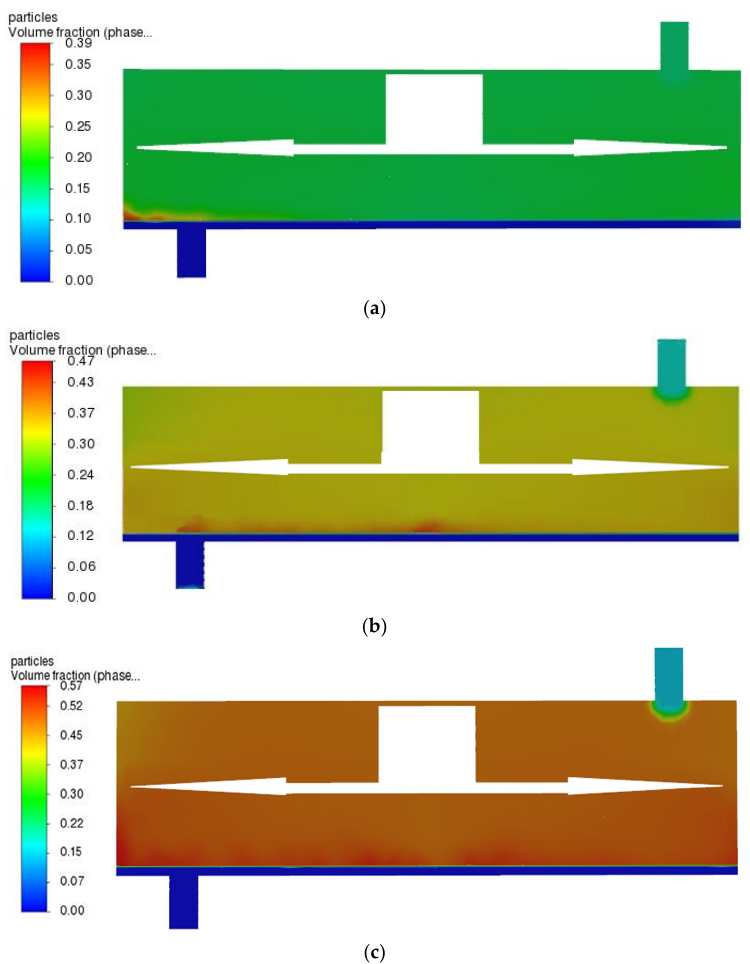
Figure 11. The particle phase distribution was simulated, showing the distribution stages of particles in the filter at different time t. ( a ) t = 2 s, ( b ) t = 20 s, ( c ) t = 36 s.